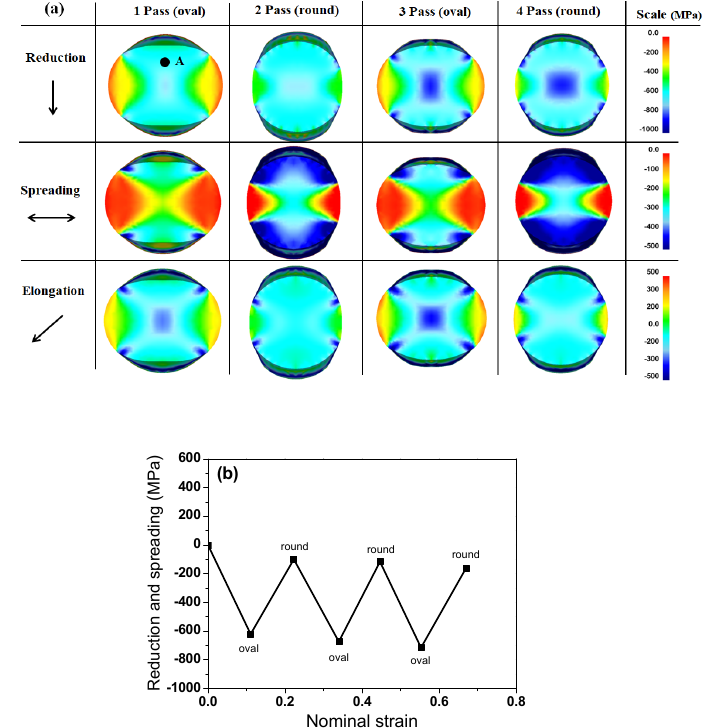
Figure 12. Comparison of the ( a ) stress contour with the direction of the wire and ( b ) variation in stain at point A marked in ( a ) of the caliber-rolled wire with the rolling pass.